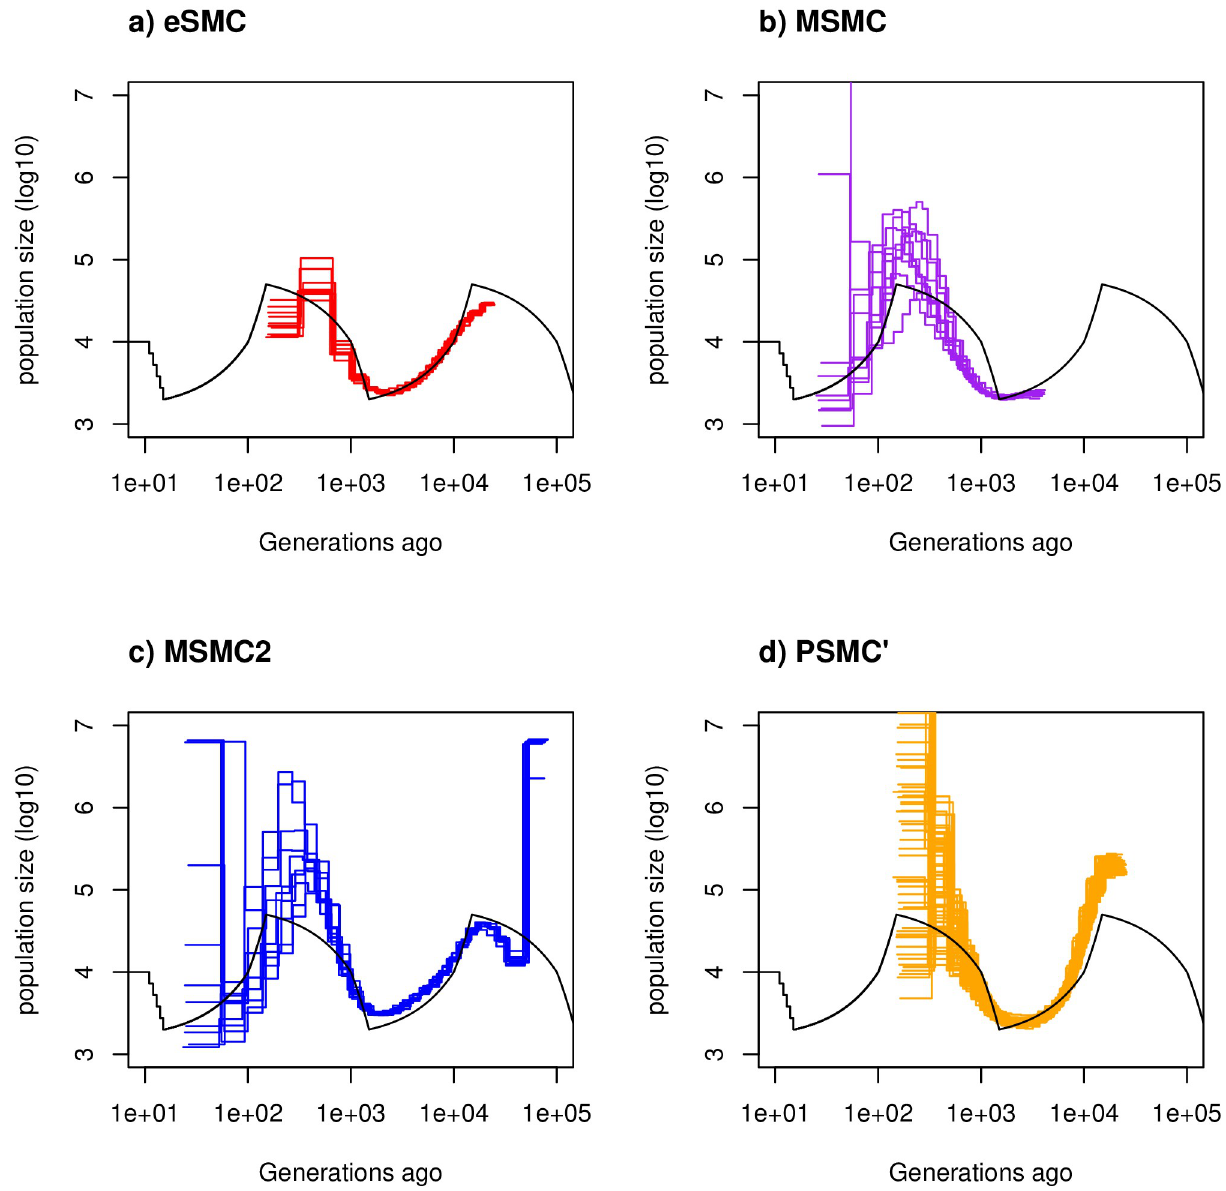
Fig 1. Estimated demographic history with no selfing or seed banking. Estimated demographic history using four simulated sequences of 30 Mb under a saw-tooth scenario with 10 replicates. Mutation and recombination rates (respectively μ and r ) are set to 1.25 × 10 − 8 per generation per bp. Therefore r ¼ r ¼ 1 . The simulated demographic history is represented in black. a) Demographic history estimated by eSMC (red). b) Demographic history y m estimated by MSMC (purple). c) Demographic history estimated by MSMC2 (blue). d) Demographic history estimated by PSMC’